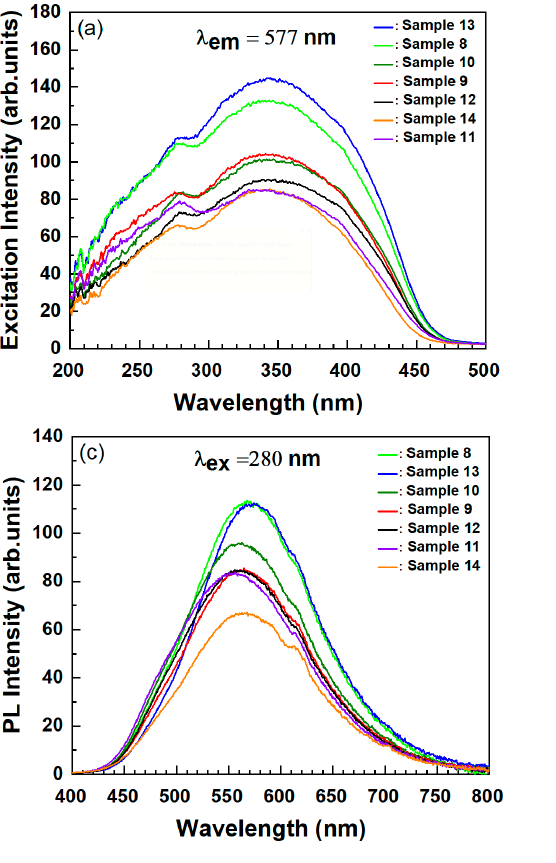
Figure 4. Excitation ( a ) and emission ( b – d ) spectra of the Ba 0 . 96 SiO 3 :0.02Eu 2+ , 0.02R +/3+ phosphors (samples 8–14).